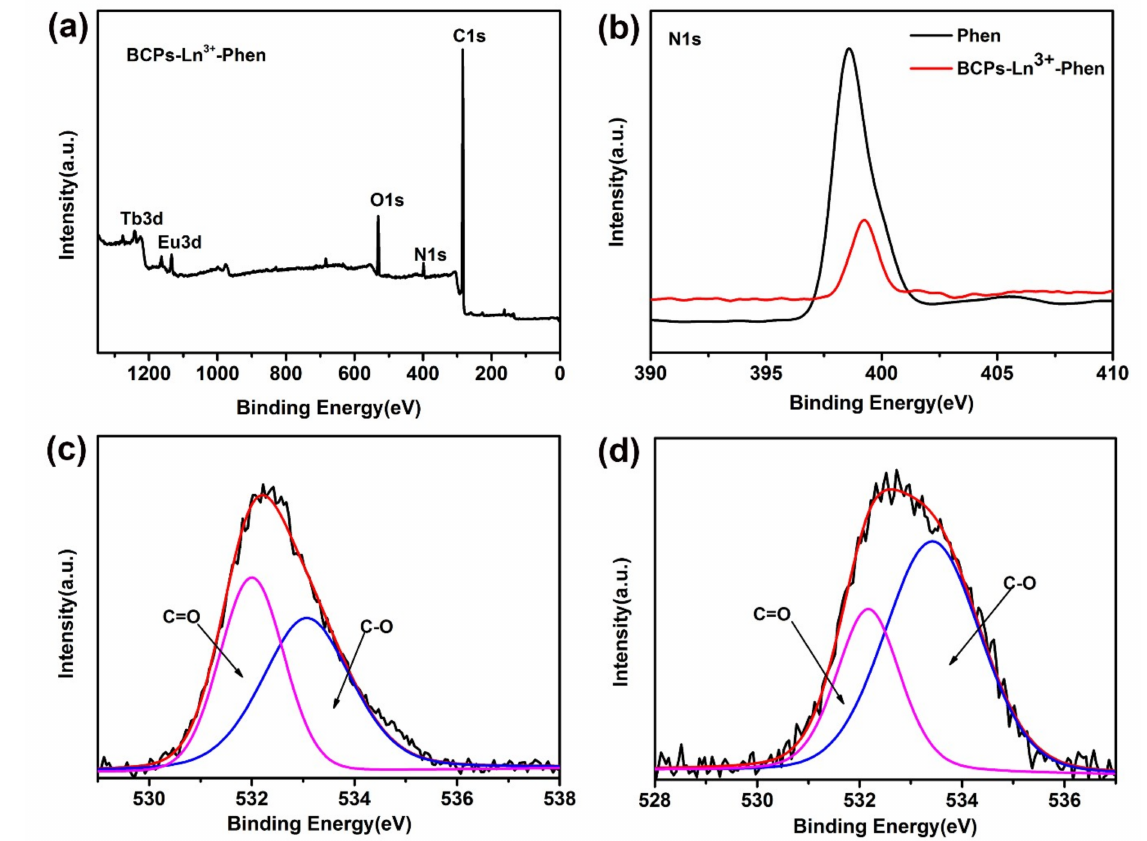
Figure 4. ( a ) XPS survey of BCP-Ln 3+ -Phen; ( b ) XPS spectra of the N1s region of Phen and BCPs-Ln 3+ -Phen; ( c ) XPS spectra of the O1s region of BCPs; ( d ) XPS spectra of the O1s region of BCPs-Ln 3+